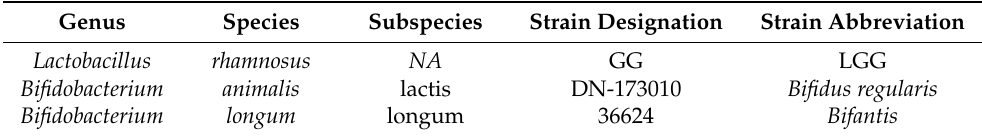
Table 1. Example of nomenclature used to identify commercial strains of probiotics. Genus Species Subspecies Strain Designation Strain Abbreviation Lactobacillus rhamnosus NA GG LGG Bifidobacterium animalis lactis DN-173010 Bifidus regularis Bifidobacterium longum